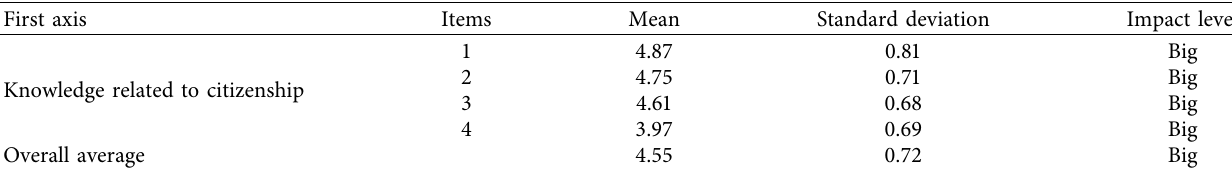
Table 3: Arithmetic averages and standard deviations of the first axis.